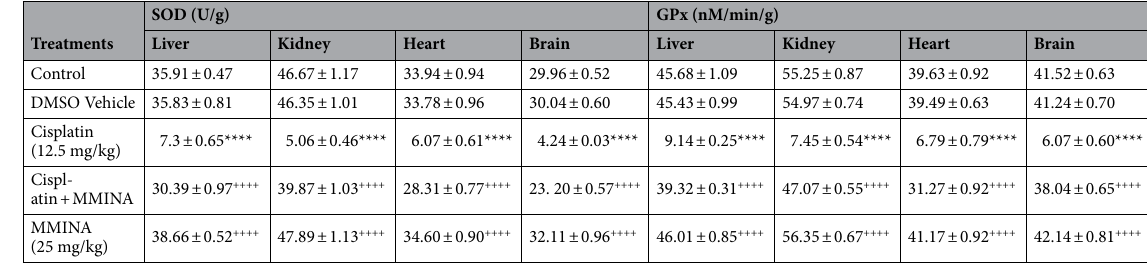
Table 2. Effect of treatment with MMINA on antioxidant parameters in cisplatin-treated rat organs. Data are mean ± SEM, (n = 6). *, **** p < 0.05 and p < 0.0001 versus Control respectively, and ++++ p < 0.0001 versus CP. Data analyzed by One-way ANOVA followed by Tukey’s multiple comparison